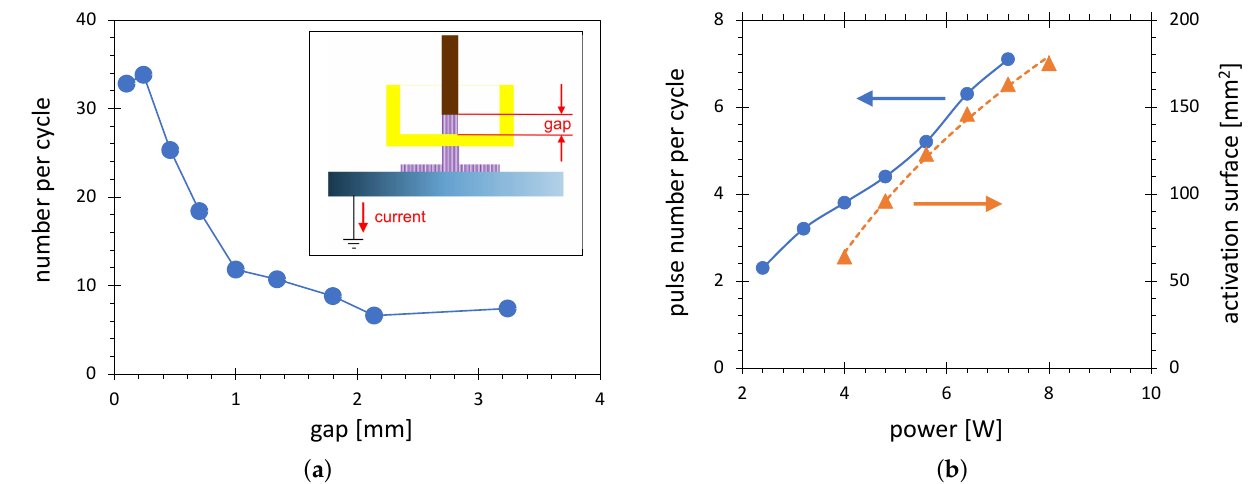
Figure 14. The number of the current pulses flowing per one cycle of PCPG oscillation between the dielectric barrier and the ground as a function of ( a ) the gap between the PCPG tip and the dielectric barrier (see the inlay drawing), and ( b ) the PCPG power for the distance between the substrate and the barrier of 0.5 mm, with dependence of the activation area on the PCPG power included for comparison. Each point represents the mean value out of 12 cycles of PCPG oscillation. The current probe TCP202, Tektronix, Inc.: Beaverton, Oregon, United States, is